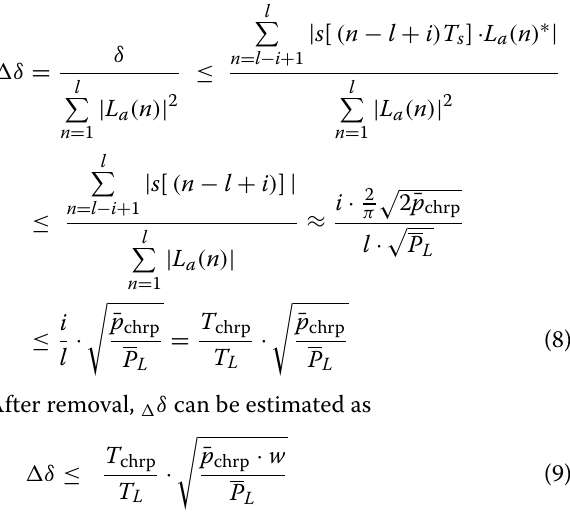
Table 2 Integrated signal parameters Long preamble Chirp